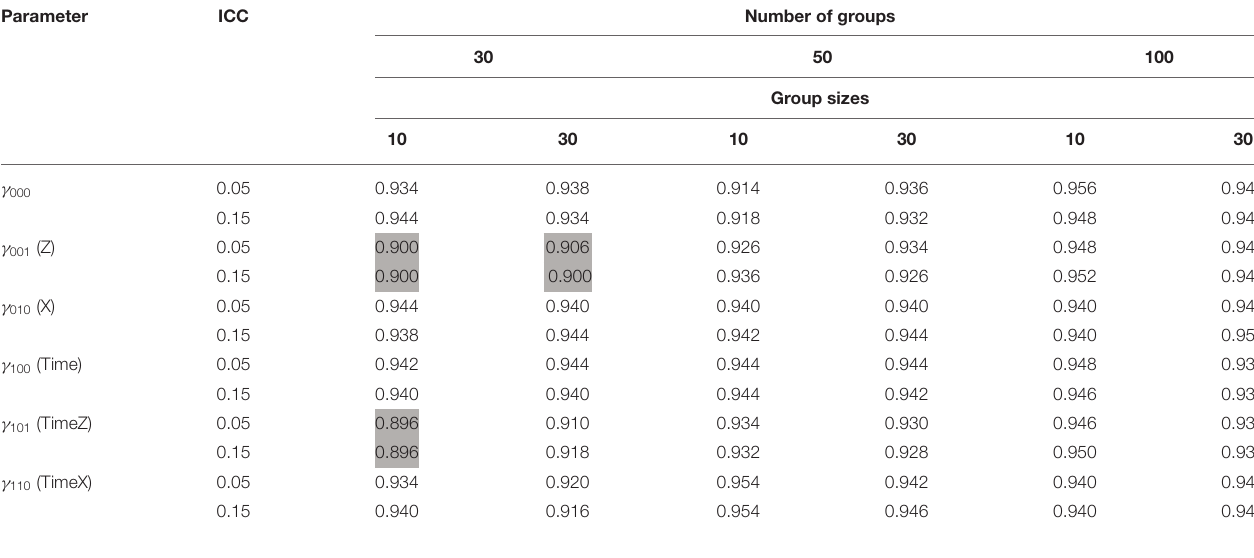
TABLE 2 | 95% coverage rate for fixed effect standard